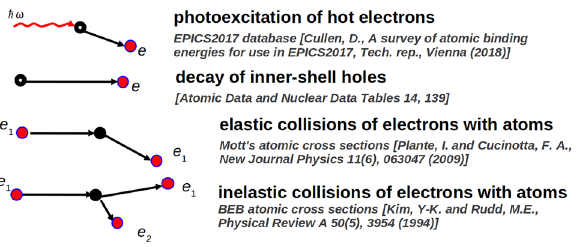
Figure 3. Schematic illustration of X-ray/XUV induced microscopic processes treated by XCascade 3D